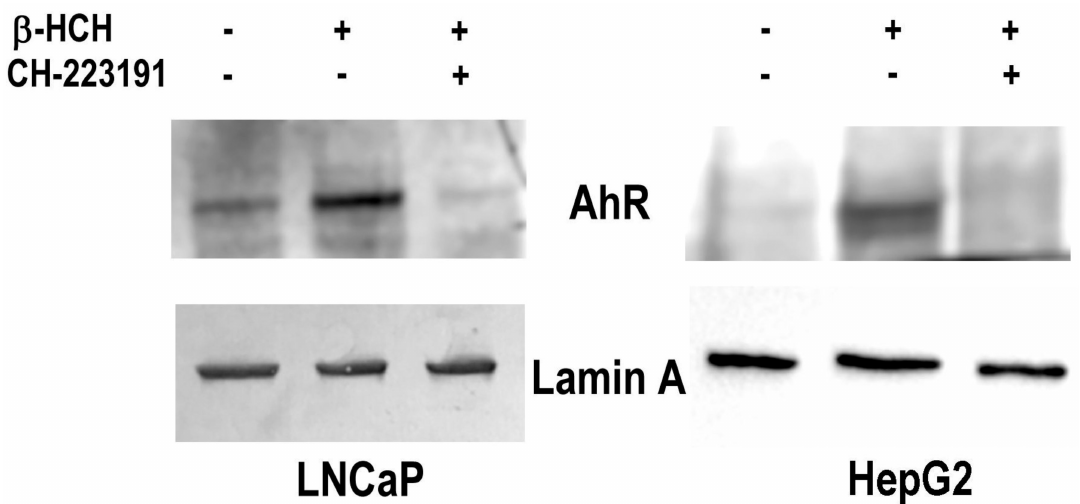
Figure 5. AhR nuclear localization in LNCaP and HepG2 cells. Western blot analysis was performed on nuclear protein extracts obtained from both prostate (LNCaP) and hepatic (HepG2) cancer cellular models treated with 10 µ M β -HCH following or not a 2 h pretreatment with 150 nM CH223191. The presence of AhR in the nuclear fraction is more noticeable in the samples corresponding to β -HCH stimulated cells with respect to control untreated cells. The amount of nuclear AhR is similar to control if cells are treated with 10 µ M β -HCH in the presence of the AhR antagonist CH223191. Lamin A was used as a specific nuclear marker and normalization protein. The experiment was repeated three times and a representative blot is